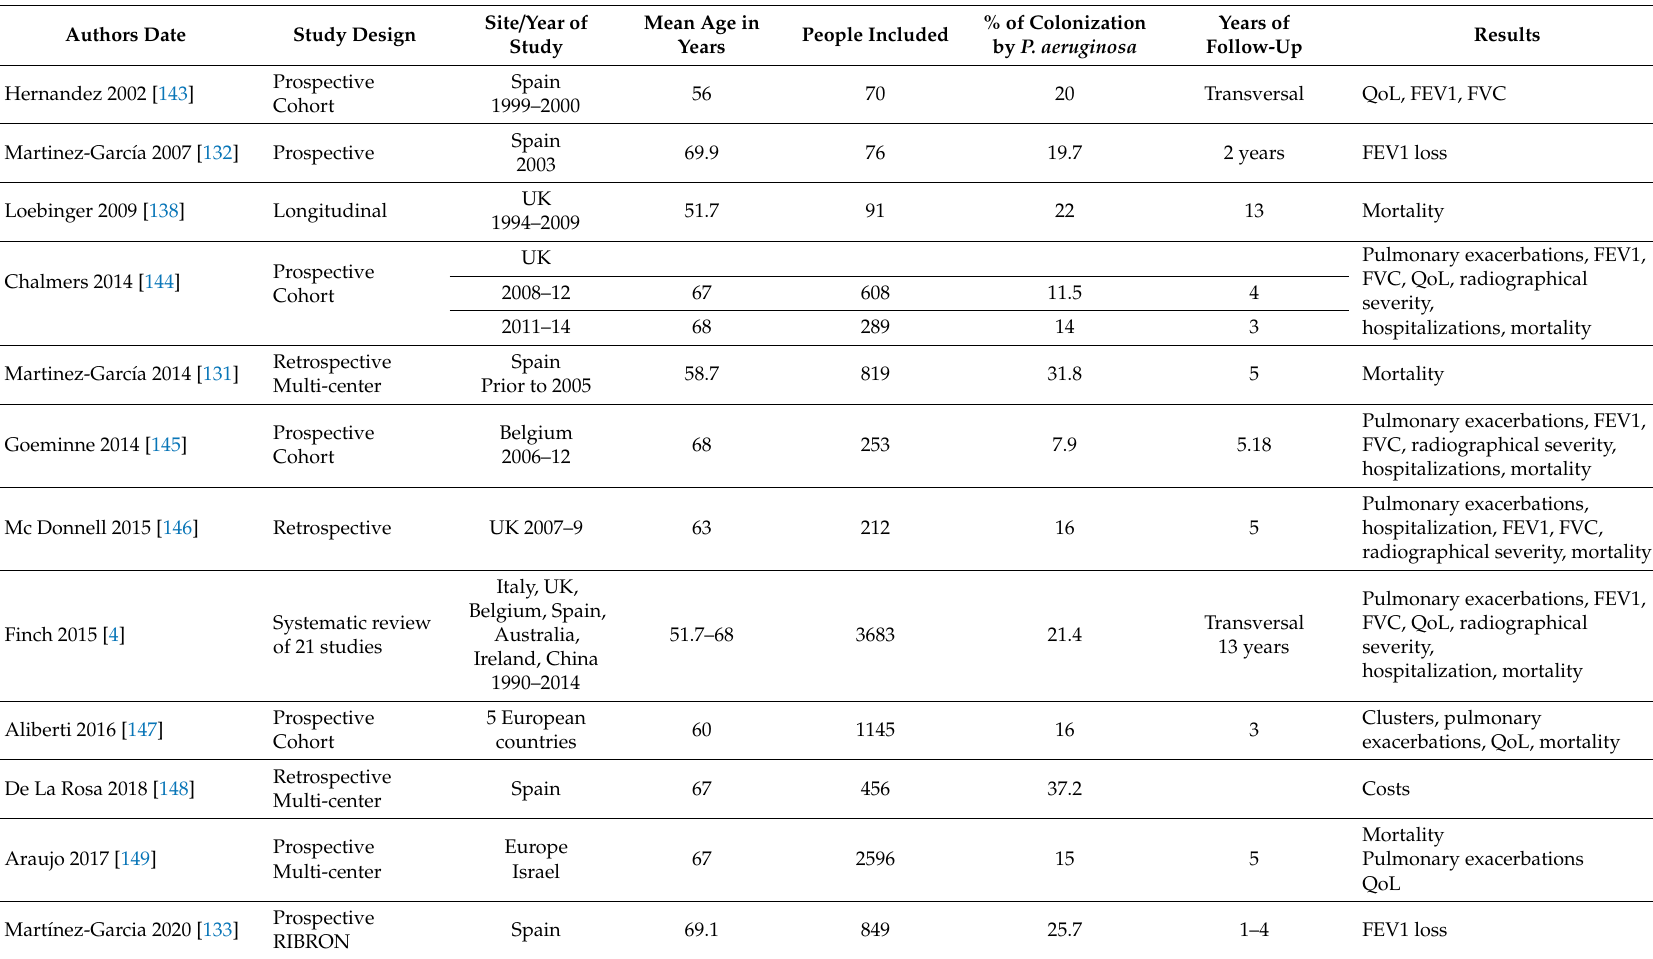
Table 3. Main studies showing the clinical impact of Pseudomonas aeruginosa on people with